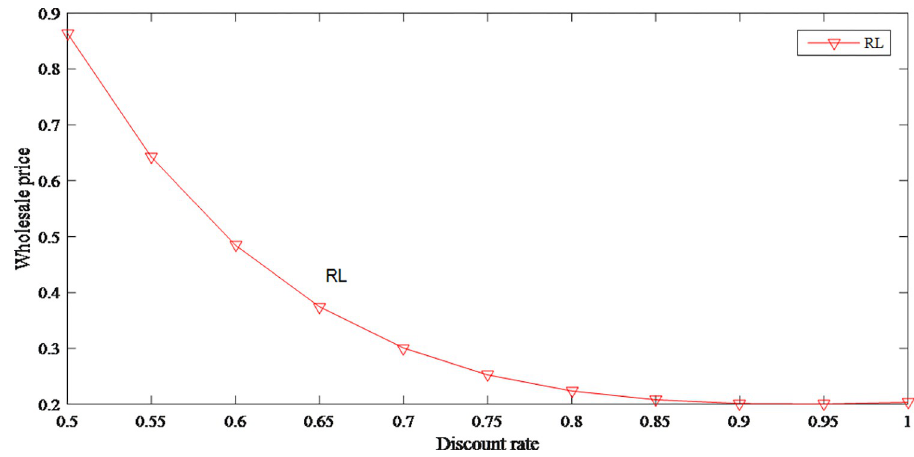
Fig 20. The impact of discount rate on wholesale price.